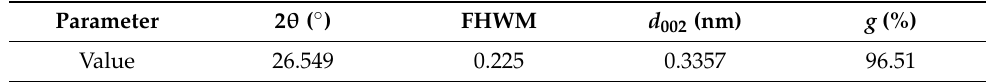
Table 1. Crystallite parameter of graphite